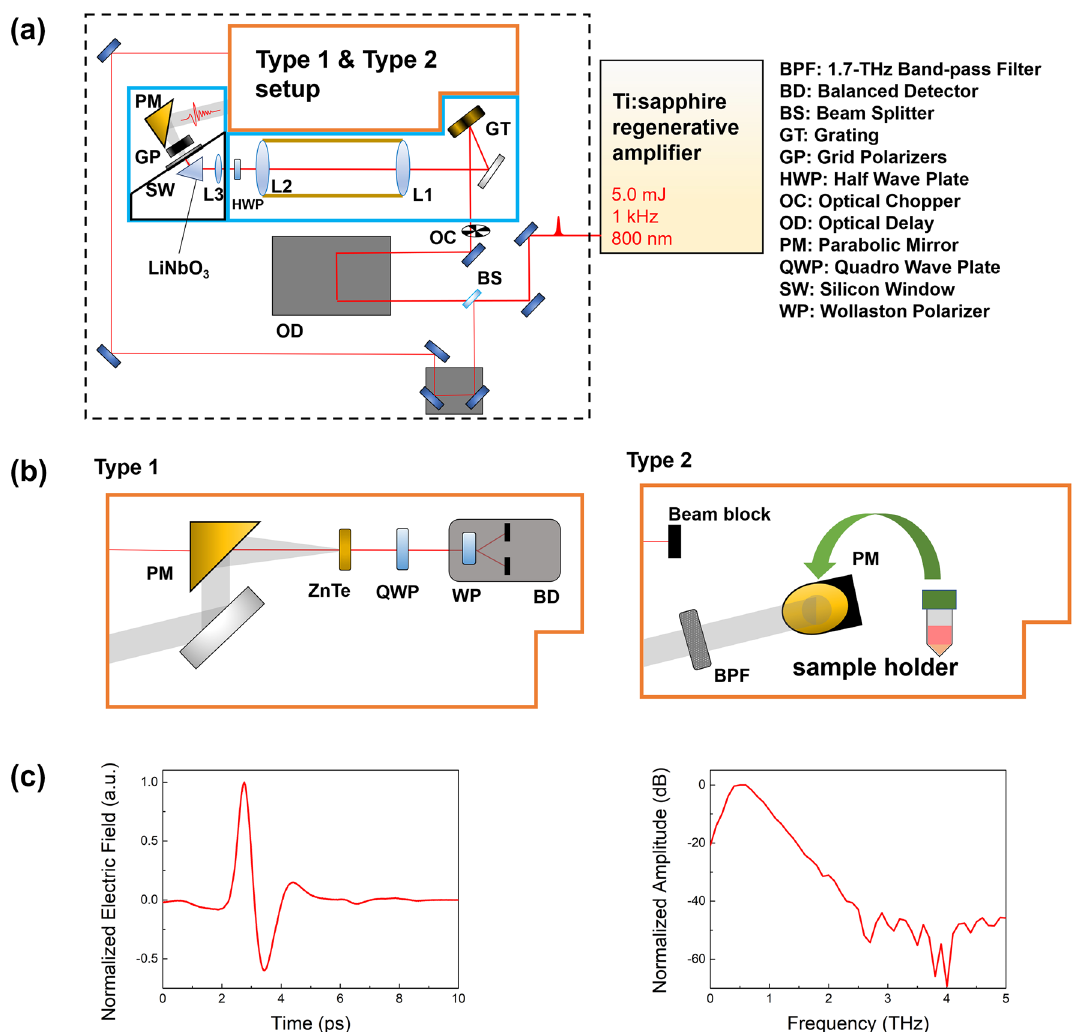
Figure 6. ( a ) Schematic of the THz generation and detection system for demethylation using resonant THz radiation. ( b ) Two types of THz setups for this study. High-power THz radiation was generated using a regenerative amplifier and a LiNbO 3 crystal and detected with a ZnTe crystal in a type-1 setup. In the type-2 setup, for THz demethylation, the THz bandpass filter limited the bandwidth around the resonance frequency of the methyl-DNA bonds. ( c ) The waveform and spectrum of THz radiation which was measured by the type-1